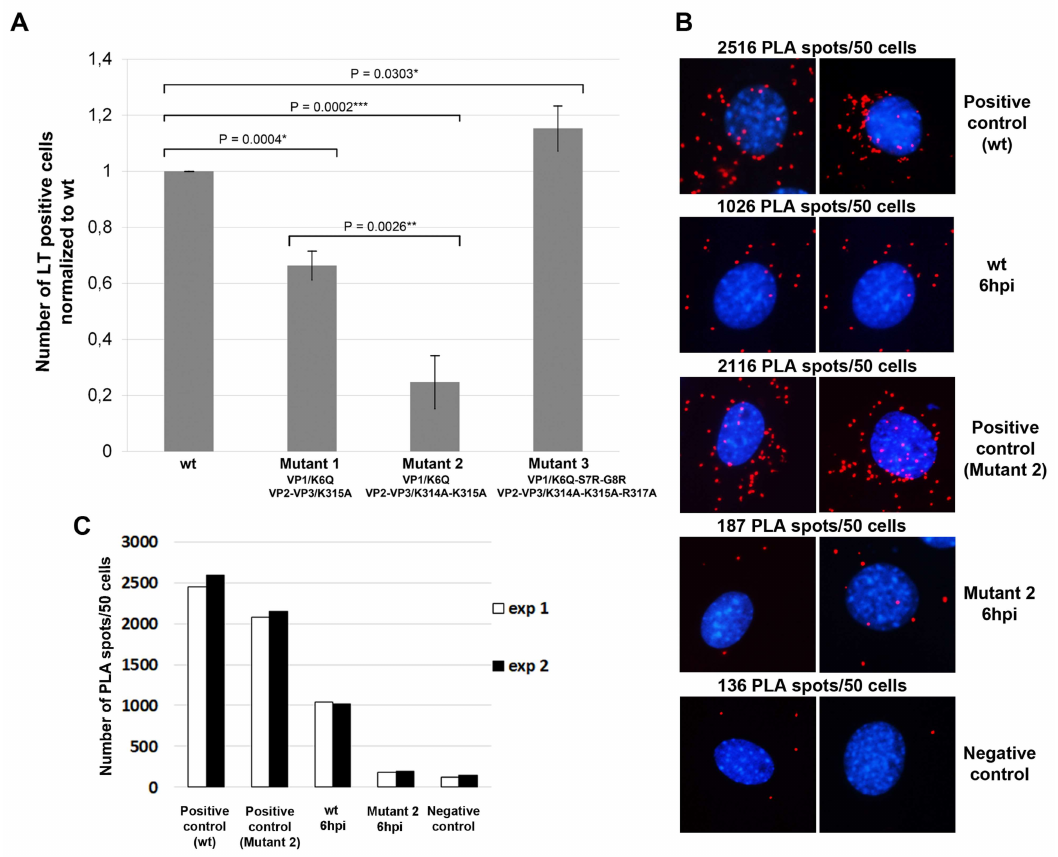
Figure 5. Effects of mutations in the NLS of VP1 and VP2/3 on viral infection and on binding of viruses to importin β 1. ( A ) 3T6 cells were infected with wt or mutant viruses 1, 2, or 3 (using virus equivalent representing 1.5 × 10 4 genomes per cell). Cells were fixed at 24 hpi and LT was stained by specific antibody. The presented data correspond to the mean of three independent experiments +/ − standard deviation (s.d.). At least 300 cells were counted per experiment. Samples were compared by the t- test. p values are given and asterisks represent statistically significant differences (* p ≤ 0.1, ** p ≤ 0.01 *** p ≤ 0.001); ( B ) PLA assay was performed in 3T6 cells at 6 hpi with wt MPyV or the mutant 2 virus (200 virus particles per cell). For this experiment, we used primary mouse and rabbit antibodies against VP1 or mouse antibody against VP1 and rabbit antibody against importin β 1. Next, the oligoprobes tagged anti-mouse and anti-rabbit antibodies were used. Red spots represent the products of amplification after oligonucleotide ligation. DNA was stained by DAPI. As controls, the infected cells were stained with two antibodies (mouse and rabbit), both against VP1 and non-infected cells were stained with anti-VP1 and anti-importin β 1 antibodies. At the top of each image, the average numbers of the PLA spots quantified in two independent experiments are presented (for each experiment spots in 50 cells were counted). The pictures were taken 20 × magnification; ( C ) The graph represents the mean values of two independent PLA